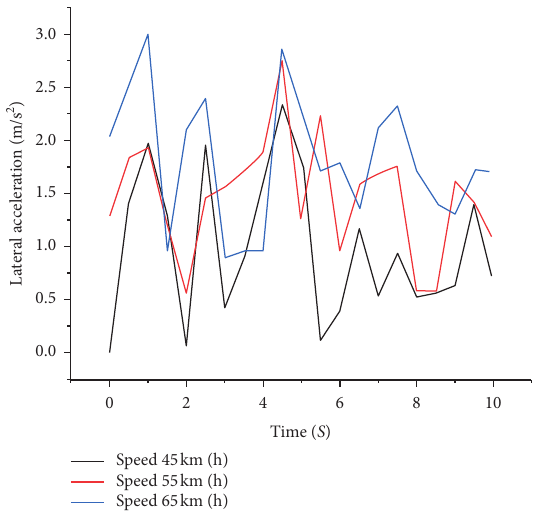
Figure 13: Lateral acceleration change of the braking lane changing scenarios.